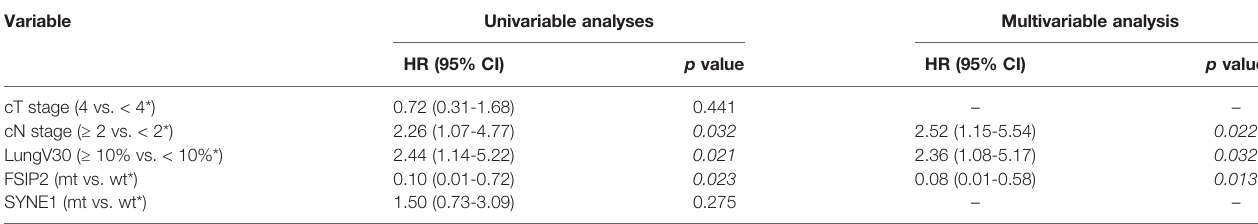
*Represent reference group; HR, hazard ratio; FSIP2, fi brous sheath interacting protein 2; SYNE1, spectrin repeat containing nuclear envelope protein 1; mt, mutated; wt, wild